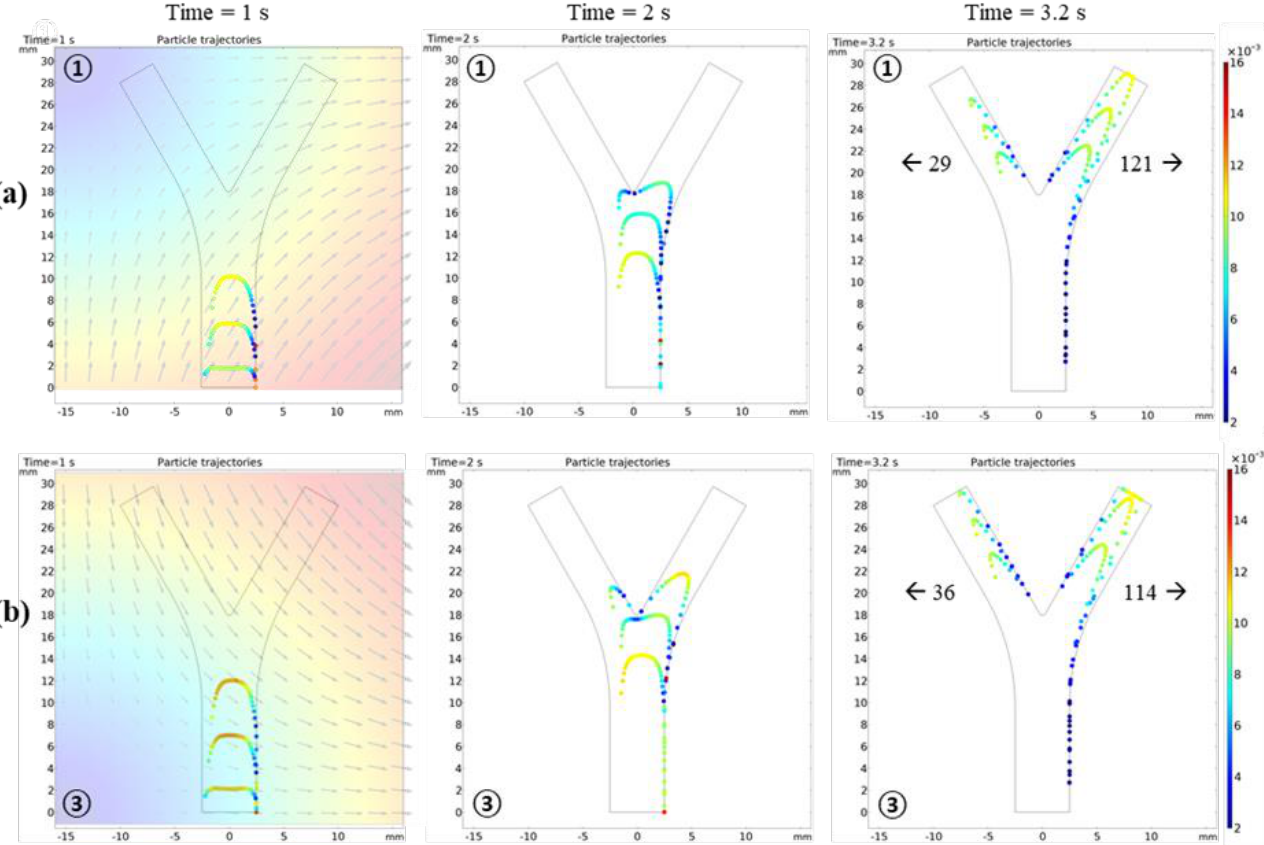
Figure 4. Particle trajectories under the influence of ∇ B . ( a ) FFP positioned at top left corner 1 (cid:13) ; ∇ B has two components: ∇ B x forces microrobots toward right bifurcation and ∇ B y acts downward, decelerating and allowing microrobots to linger with ∇ B x . ( b ) FFP positioned at lower left corner 3 (cid:13) ; compared with to 1 (cid:13) , ∇ B y here is upward, accelerating the particles upward and leaving less time with ∇ B x (hence, it is less efficient).